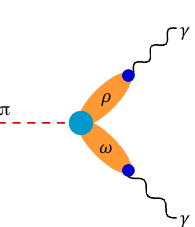
Figure 4. Pion TFF in the large- N c